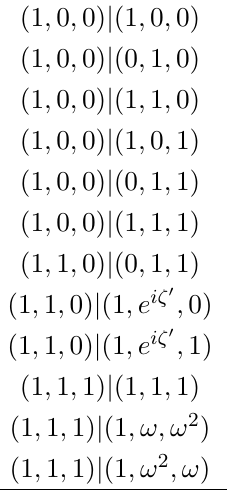
Table 2 . List of VEV directions for the potential of two triplets of (cid:1)(3 n 2 ), V CP , (1 ; 0 ; 0) j (1 ; 0 ; 1) and (1 ; 0 ; 0) j (1 ; 1 ; 0) merge. (cid:16) 0 remains free and nothing happens to 23 the orbits with ! s. Lastly, for the CP symmetry with X ’’ 0 , ~ s Additionally, (1 ; 1 ; 1) j (1 ; !; ! 2 ) and (1 ; 1 ; 1) j (1 ; 1 ; 1) merge. For the CP symmetry